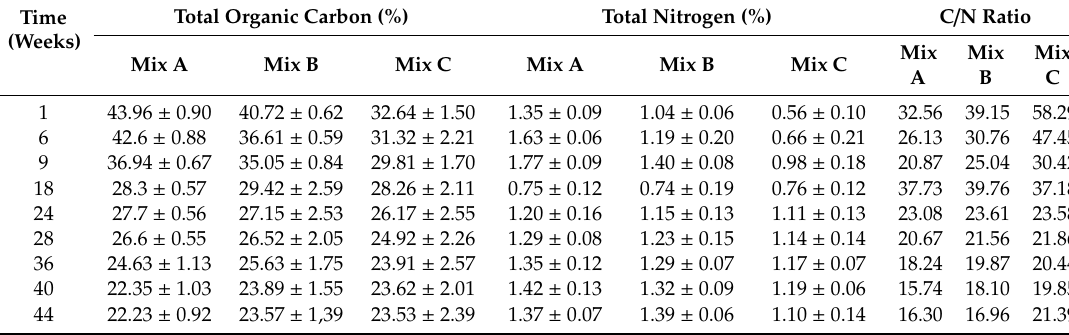
Table 3. Changes in total organic carbon, total nitrogen, and C / N ratio during the composting of di ff erent